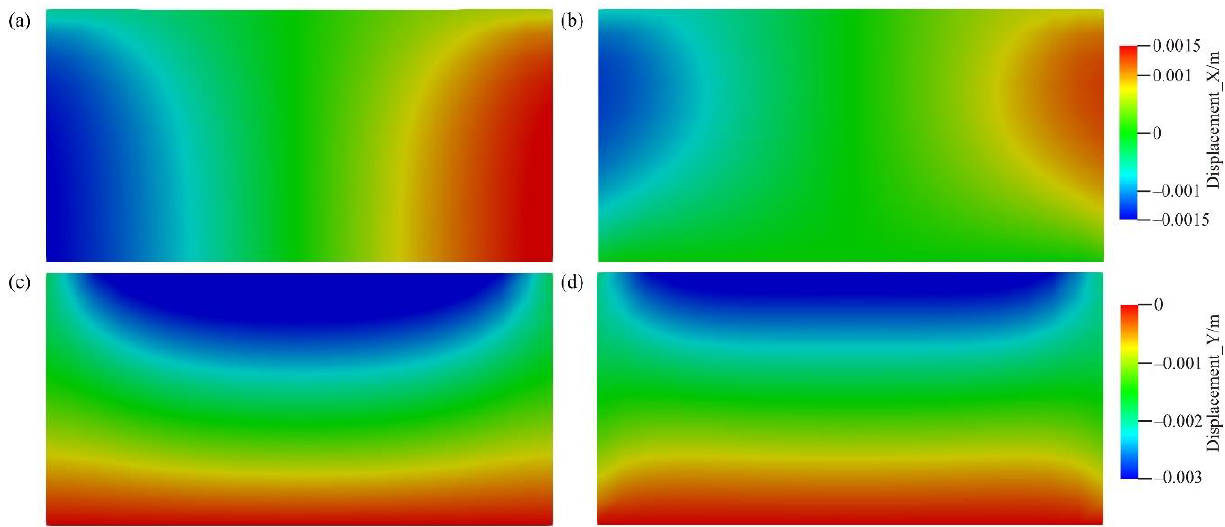
Figure 5. Horizontal ( a , b ) and vertical ( c , d ) displacements of the elastic block when the coefficient of friction is 0.0 and 0.3. Figure 5a,b show the horizontal displacement when the coefficients of friction are 0.0